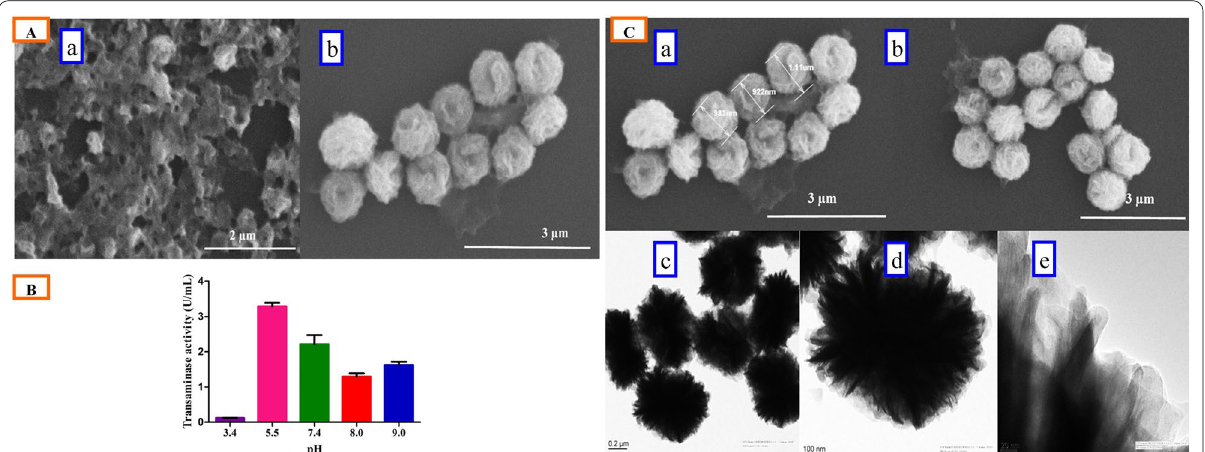
Fig. 4 A SEM images of transaminase hybrid nanoflowers synthesized at, a pH 5.5, b pH 7.4. B TA activity of TA@Cu 3 (PO 4 ) 2 NF synthesis at different pH. C Characterization of hybrid NFs synthesized under optimum condition, a , b SEM images of TA@Cu 3 (PO 4 ) 2 NF, c TEM image of TA@Cu 3 (PO 4 ) 2 NF, d magnified TEM image of c , e magnified TEM image of